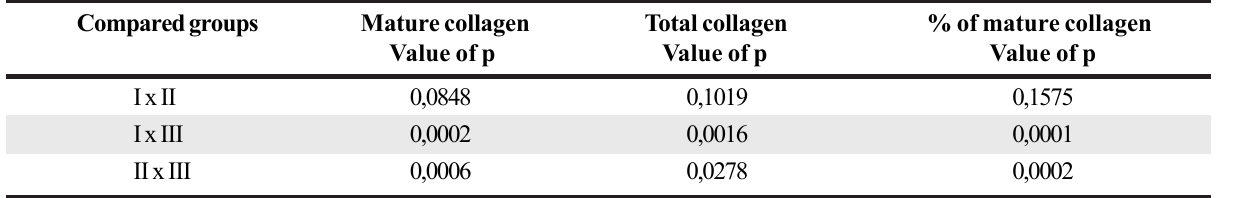
TABLE 4 - Values of “p” in the comparisons of the groups two-by-two Compared